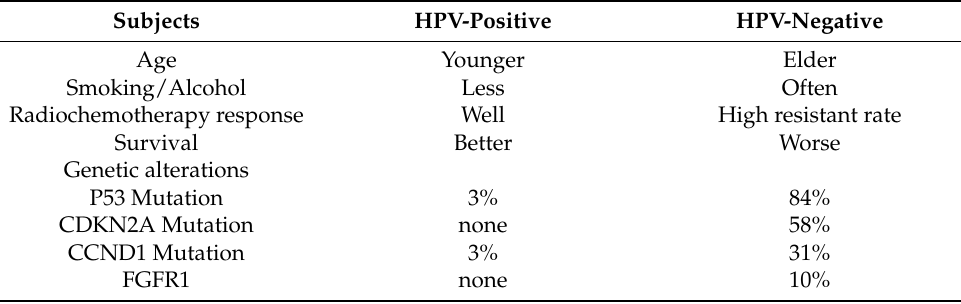
Table 1. Differences between HPV-positive and negative oropharyngeal cancer